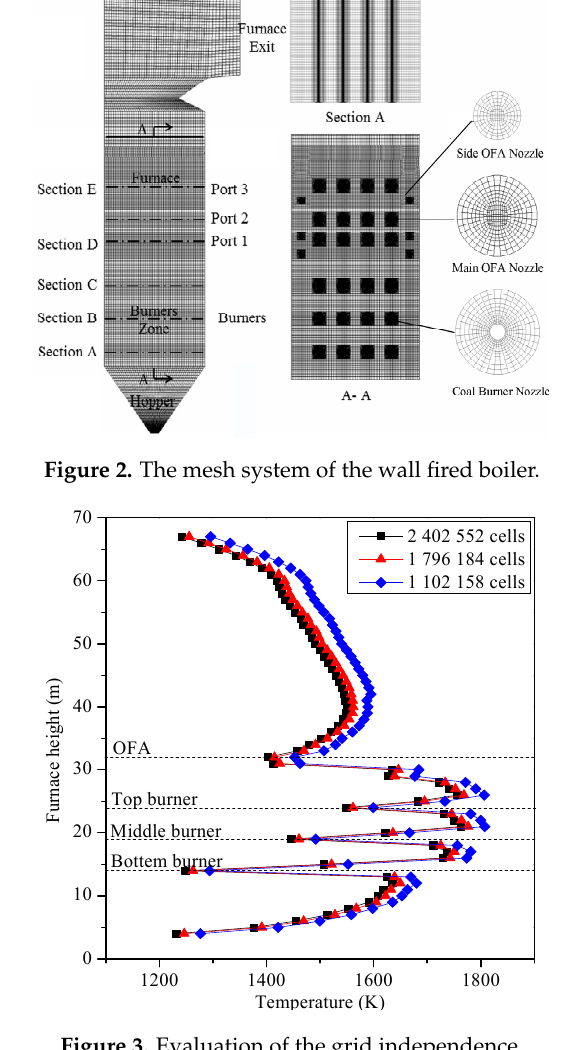
Figure 3. Evaluation of the grid independence.